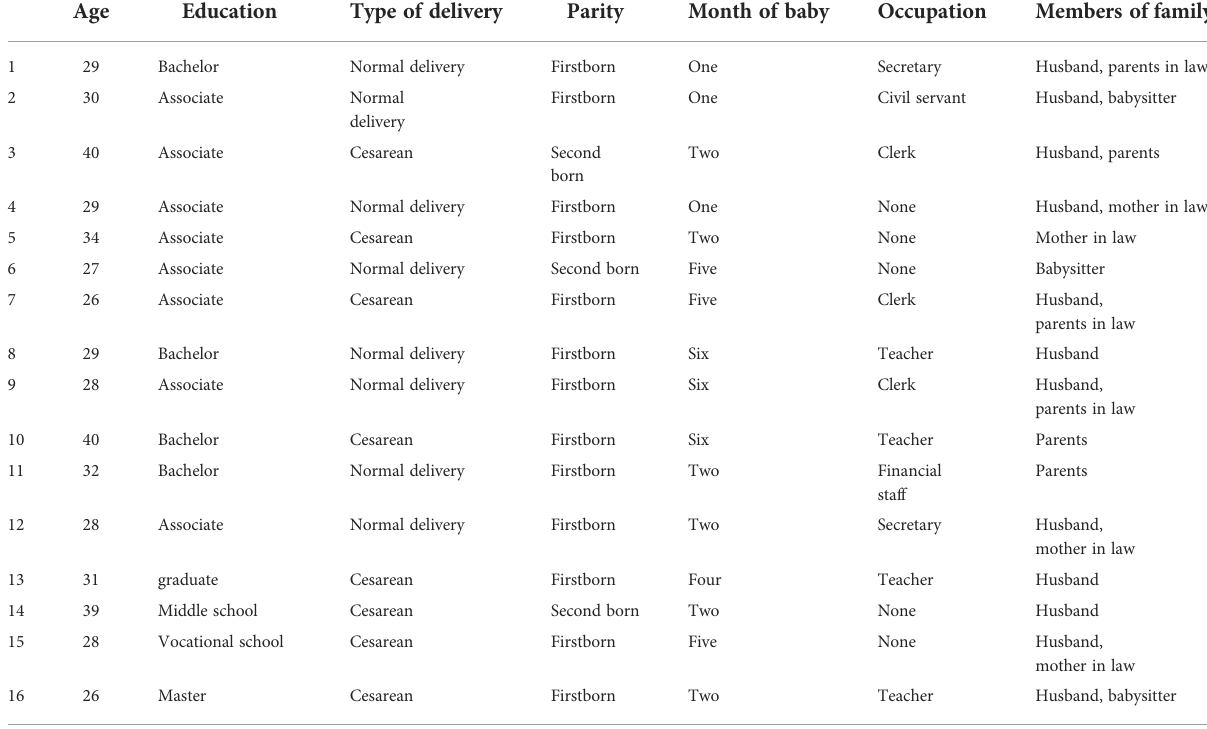
TABLE 1 Demographic data of the